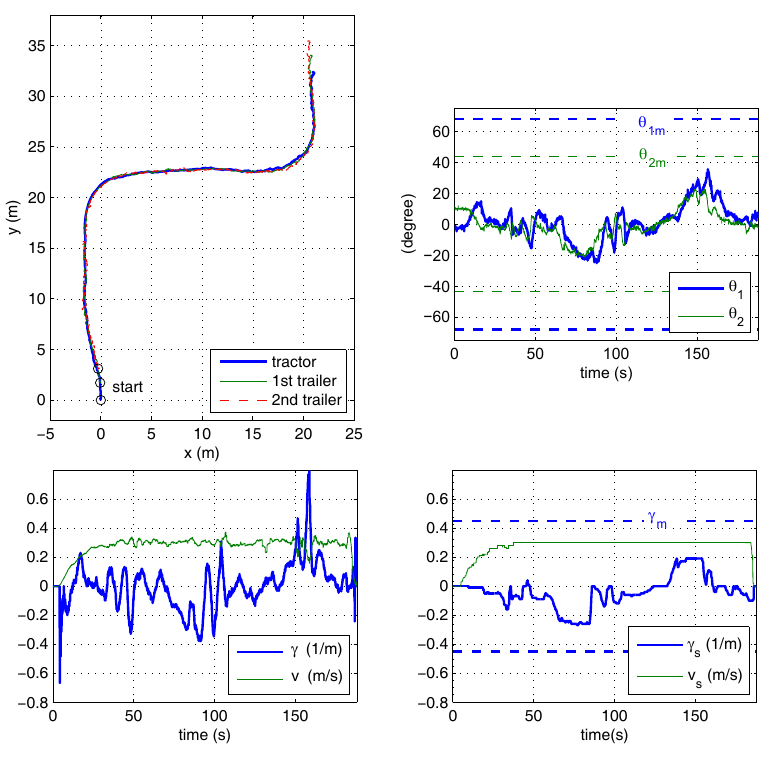
Figure 8. Reverse driving with the off/off axle setup: paths of the tractor and trailers ( top left ); hitch angles with corresponding mechanical limits ( top right ); driver commands and curvature limitations ( bottom right ); speed and curvature of the actual tractor ( bottom left ).